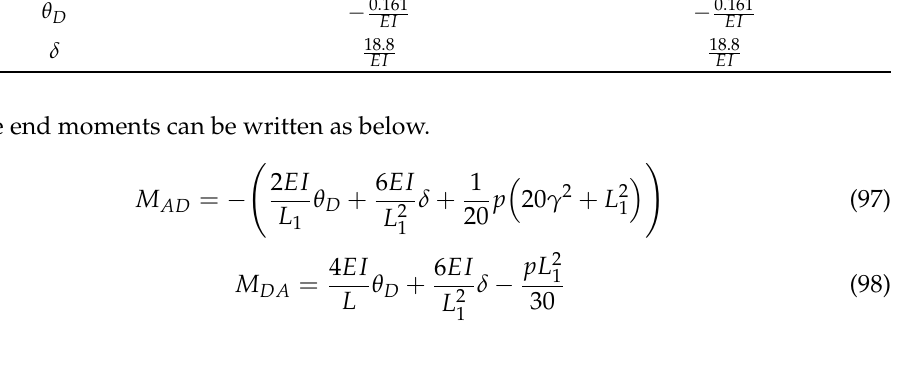
Table 2. Unit displacements for a frame system subjected to horizontal triangular load [64]. Unit